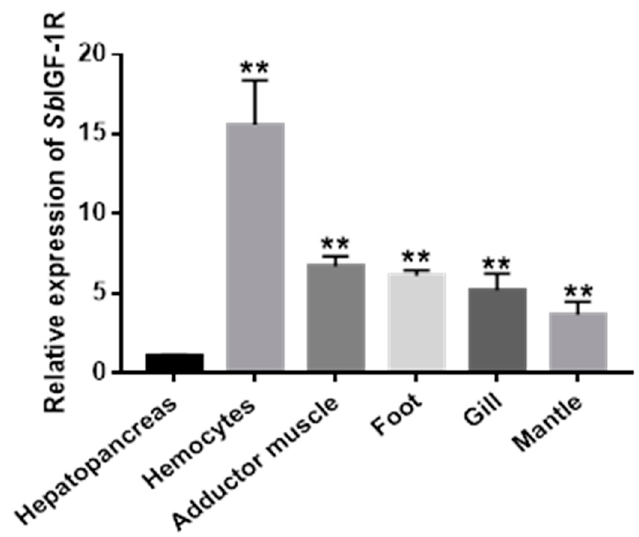
Figure 5. Relative mRNA expression of Sb IGF-1R in healthy ark clams’ tissues detected by qRT-PCR. The transcript levels in the hepatopancreas, hemocytes, adductor muscle, foot, gill, and mantle were normalized to that in the hepatopancreas. The asterisks indicate significant differences: ** p < 0.01.